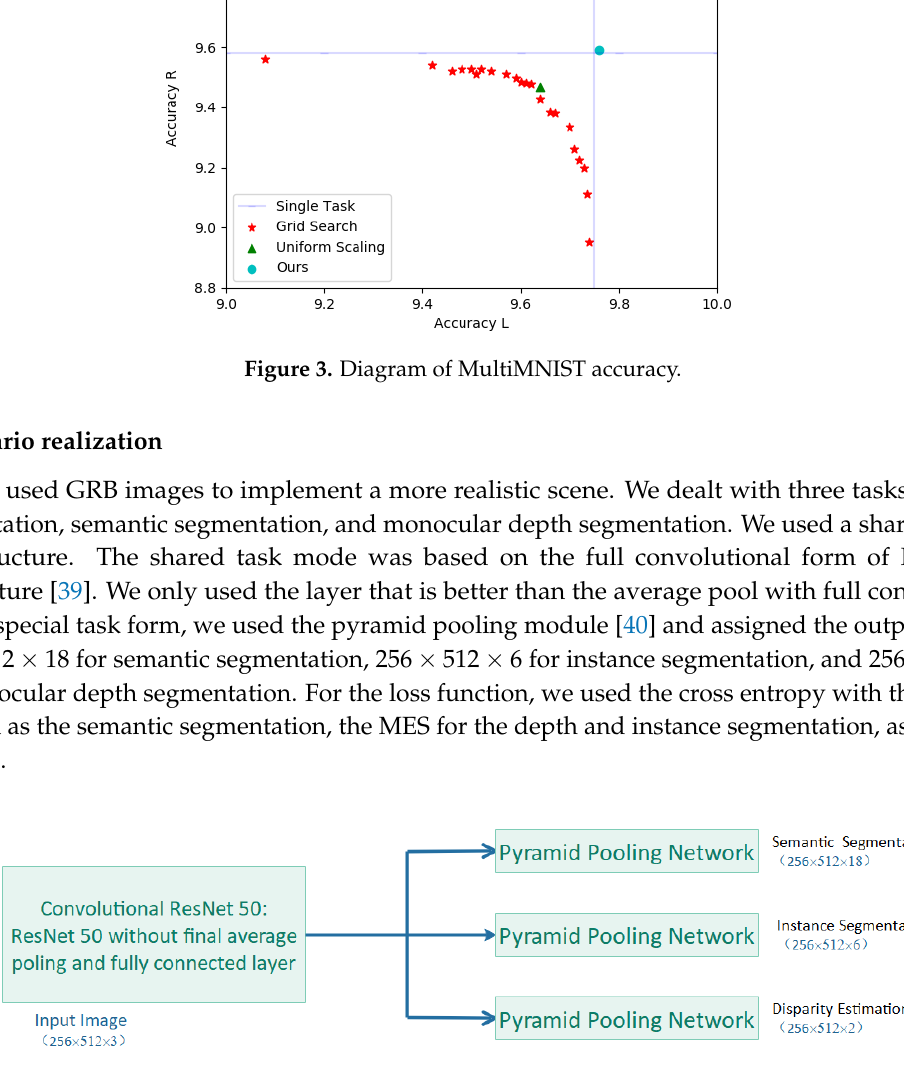
Figure 4. Scene realization experiment structure